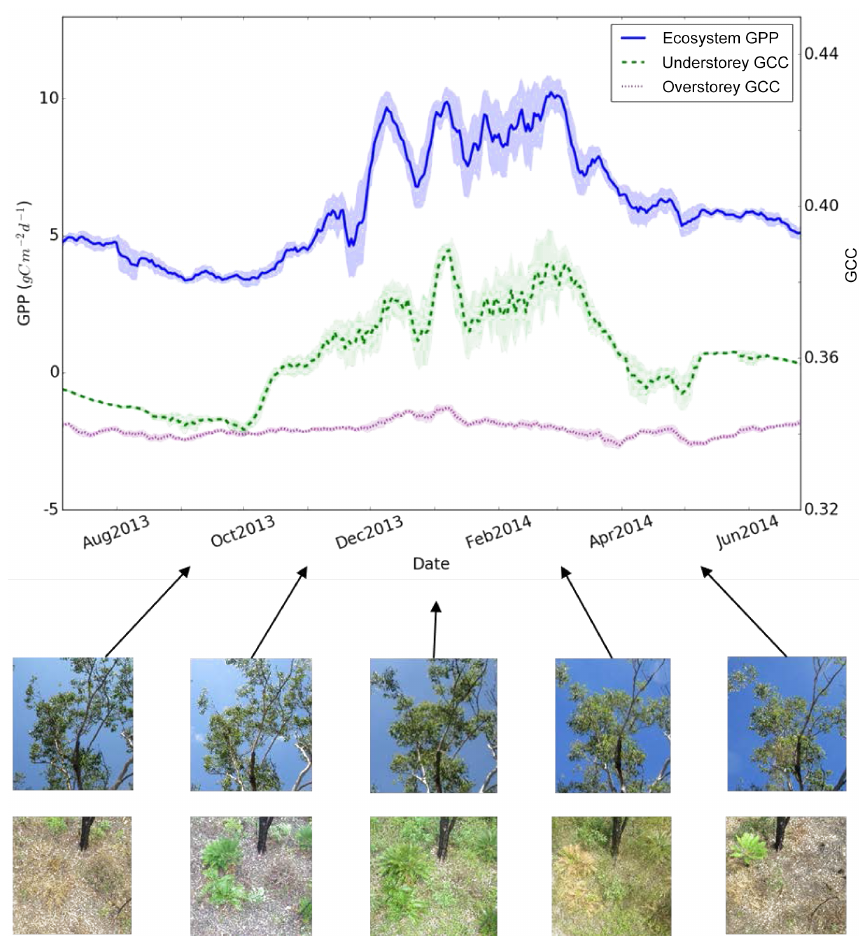
Figure 5. Ecosystem gross primary productivity (GPP) and green chromatic coordinates (GCC) for the overstorey and understorey, with region of interest (ROI) image examples, at the Howard Springs tropical savanna OzFlux site (Fig. 2; site 2, AU-How), Northern Territory, Australia. Data are shown as an 8-day centred running mean with ± 90% confidence